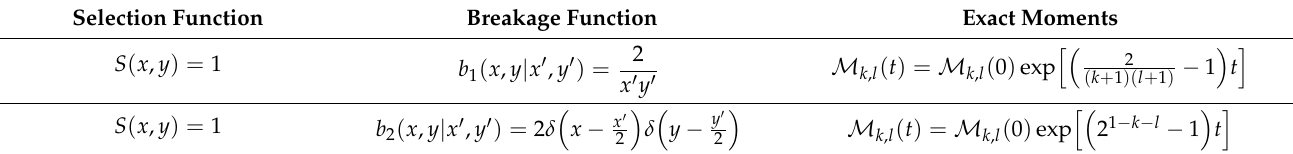
Table 1. Exact moment functions for S = 1 and breakage functions b 1 , b 2 . Selection Function Breakage Function Exact Moments